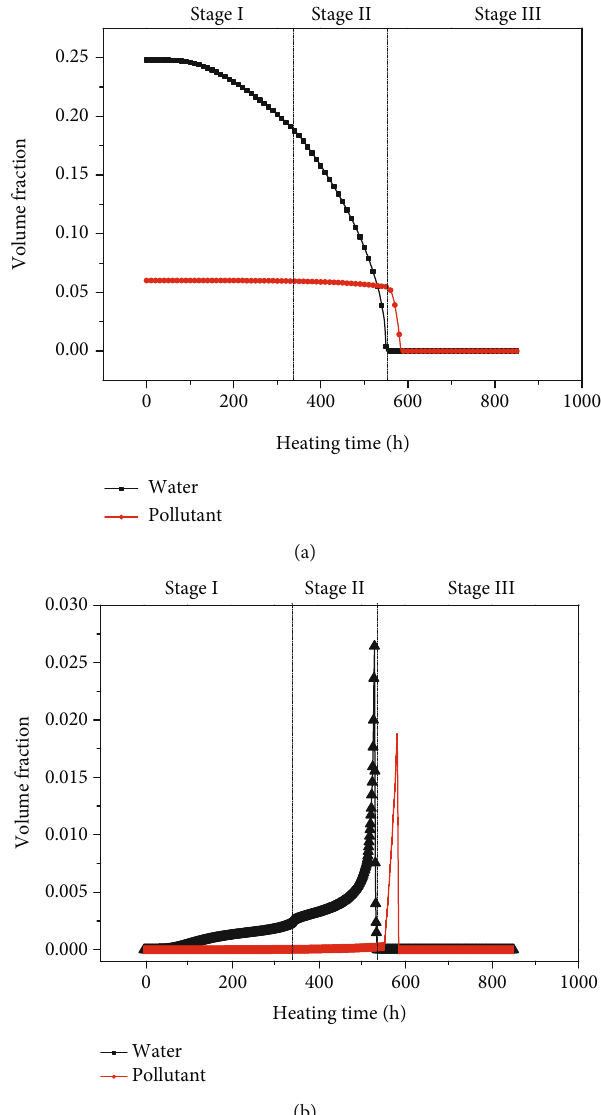
Figure 5: Volume fraction of toluene and water at the boundary soil (a) and in the o ff -gas